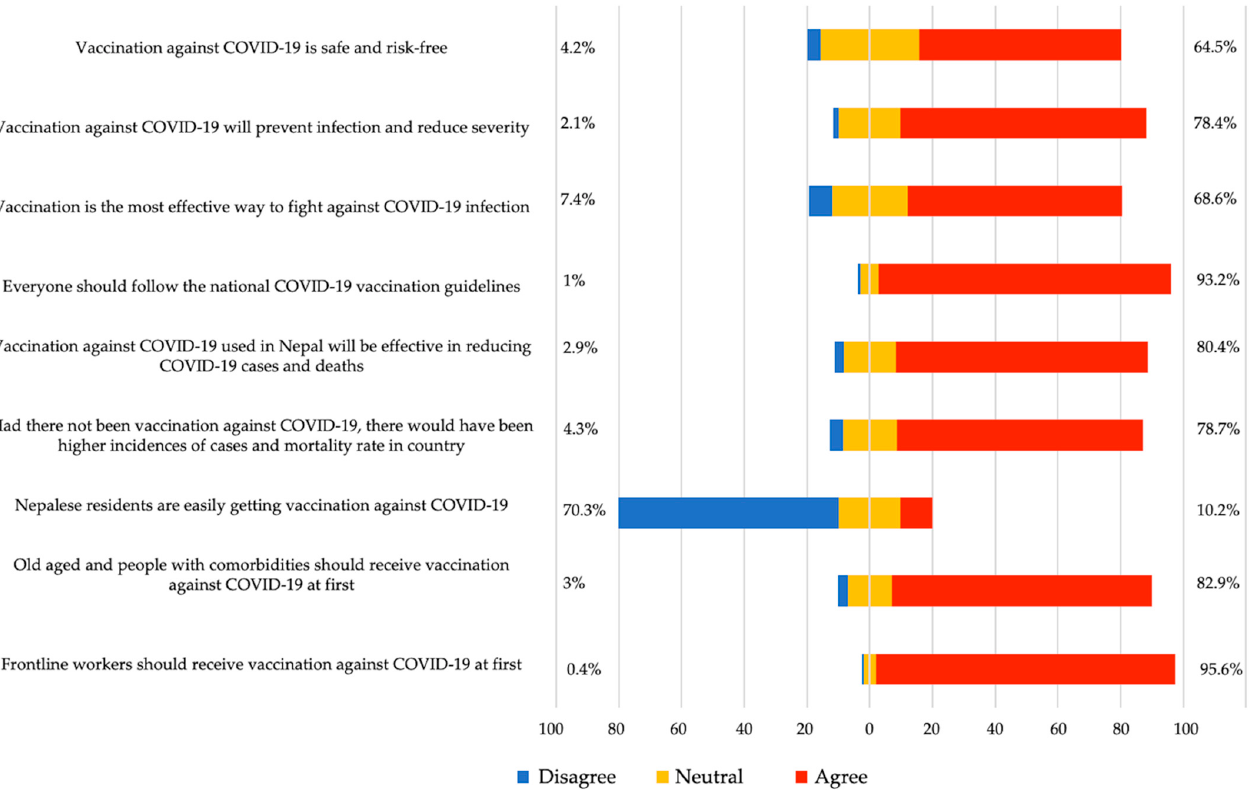
Figure 1. Perception of participants towards COVID ‐ 19 vaccines and vaccination in Nepal.